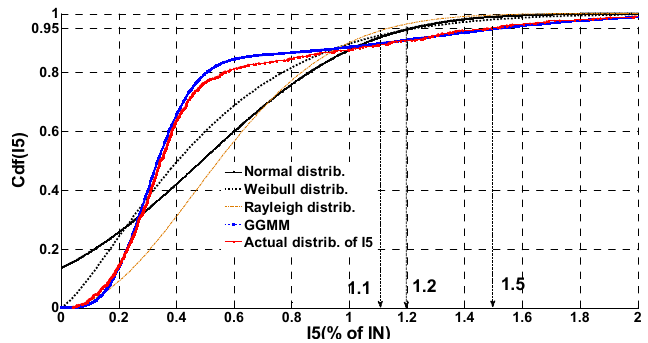
Figure 13. Cdf of the fifth harmonic current approximated by different